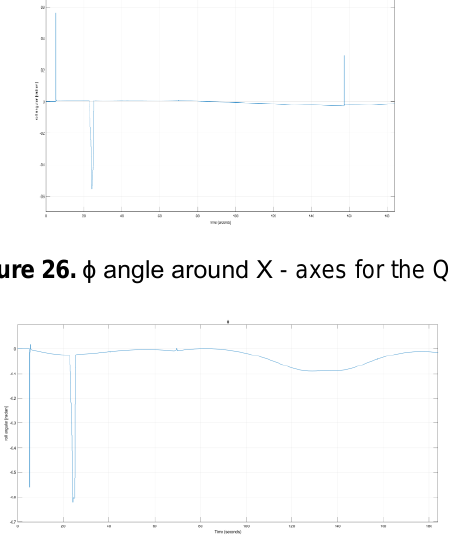
Figure 27. θ angle around Y- axes for the